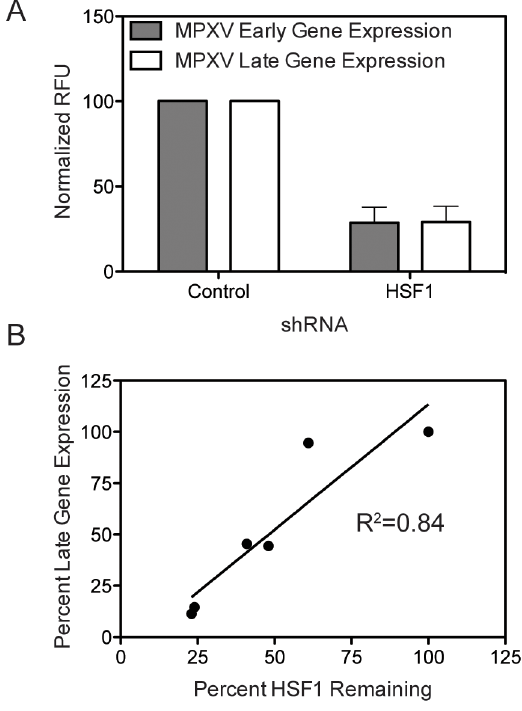
Figure 8. HSF1 is also a critical host factor for monkeypox infection. (A) HSF1-knockdown cells infected with a modified MPXV expressing GFP under an early promoter and dsTomato Red under a late promoter show a decrease in MPXV infection, as measured by early and late gene expression normalized to MPXV infection in cells with no protein depletion. (B) The level of HSF1 protein remaining in the cell following knockdown (x-axis) correlates with the inhibition of MPXV late gene expression during infection